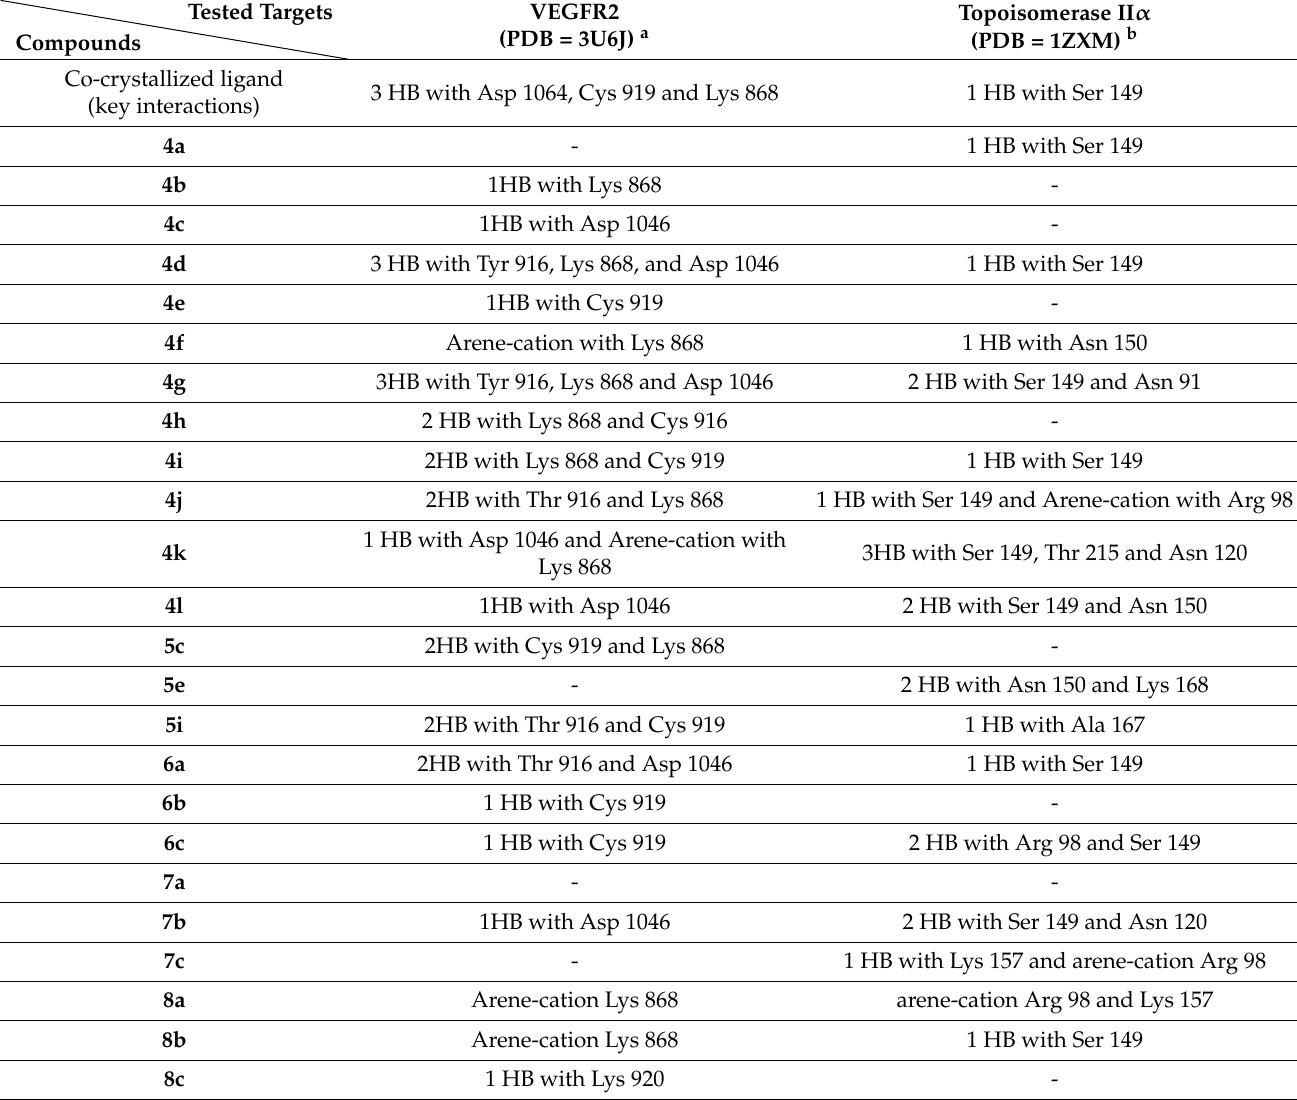
Table 1. Analysis of ligand-receptor interactions of the docked compounds towards two